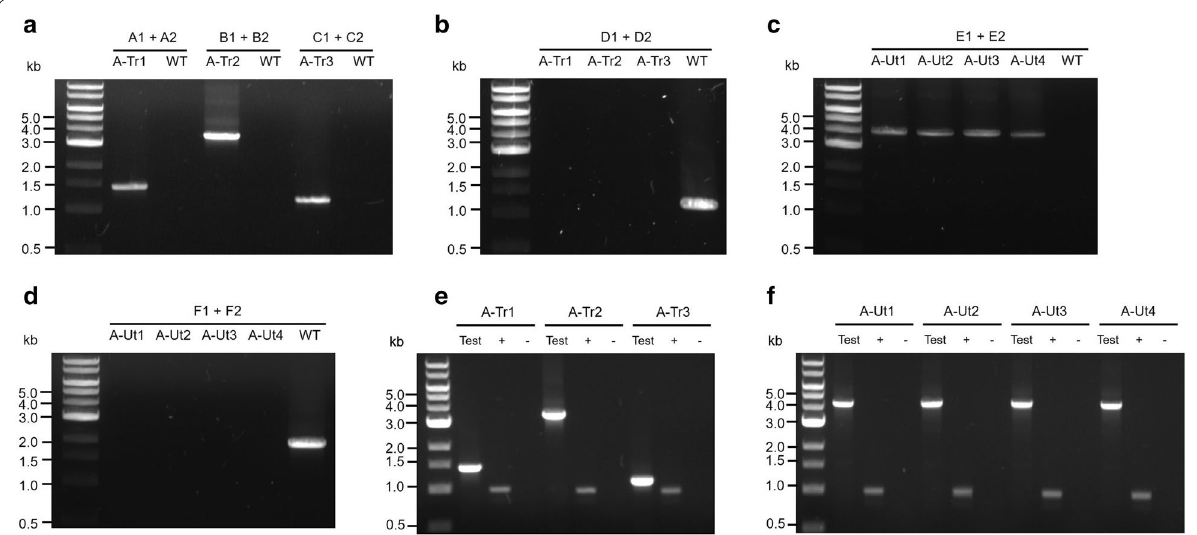
Fig. 3 Evaluation of transformation, chromosomal segregation and transcription. a The presence of transporter genes was verified with the help of primers A1-A2 ( araE ), B1-B2 ( araFGH ) and C1-C2 ( araJ ). The primers produced fragments of ~1.42, ~3.58 and ~1.18 kb, respectively. WT genomic DNA served as the negative control. b Chromosomal segregation was examined with the help of primers D1-D2. In the absence of uninterrupted neutral site 1, the primers failed to generate PCR products, whereas the WT genomic DNA serving as the positive control yielded a ~1.20 kb product. c The presence of araBAD gene set was verified with the help of primers E1-E2. The primers produced ~4.19 kb band. WT genomic DNA was used as the negative control. d Chromosomal segregation was verified with the help of primers F1-F2. In the absence of uninterrupted neutral site 2, the primers failed to generate any PCR product, whereas the WT genomic DNA included as the positive control yielded a ~1.94-kb product. (e) Transcription of the transporter genes was demonstrated with the help of primers A1-A2 ( araE ), B1-B2 ( araFGH ) and C1-C2 ( araJ ), represented as ‘Test’. The primers generated products of ~1.42, ~3.58 and ~1.18 kb, respectively. As the positive controls ( ), transcription of petA (~0.99-kb) + was examined in the cDNA templates. As the negative controls (-), amplification of the transporter genes from the corresponding RNA samples was evaluated. (f) Transcription of araBAD gene set was demonstrated with the help of primers E1-E2, represented as ‘Test’. The primers generated products of ~4.19 kb. As the positive controls ( ), transcription of petA (~0.99-kb) was examined in the cDNA templates. As the negative controls (-), + amplification of the catabolic gene set from the corresponding RNA samples was